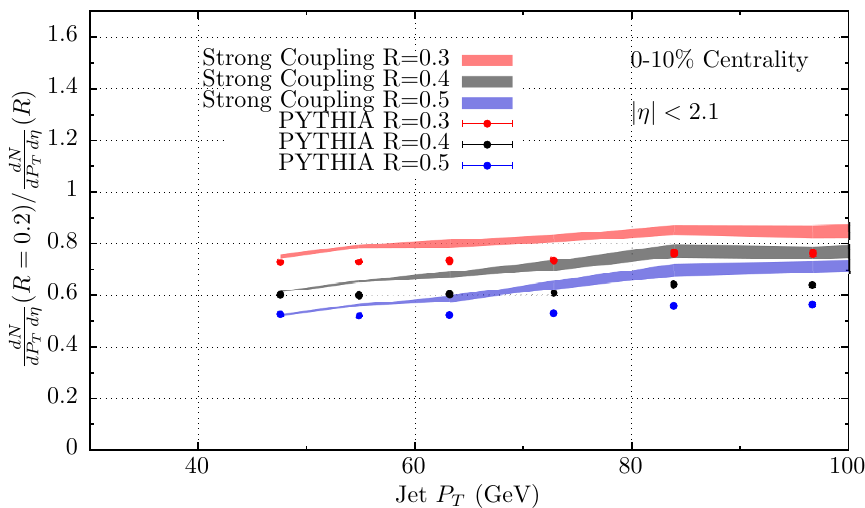
Figure 9 . Ratio of the spectra of jets reconstructed with the anti- k t parameter R = 0 : 2 to the spectrum of jets reconstructed with various larger values of R as a function of the reconstructed jet p t . The colored bands correspond to the prediction of our hybrid model, with no broadening ( K = 0) and including the e(cid:11)ects of the backreaction of the medium. The dots are the predictions for jets in vacuum, in proton-proton collisions as described by Pythia . As explained in the text, the fact that the three colored bands are closer together than the three sets of dots are is due to the fact that wider jets lose more energy than narrower jets